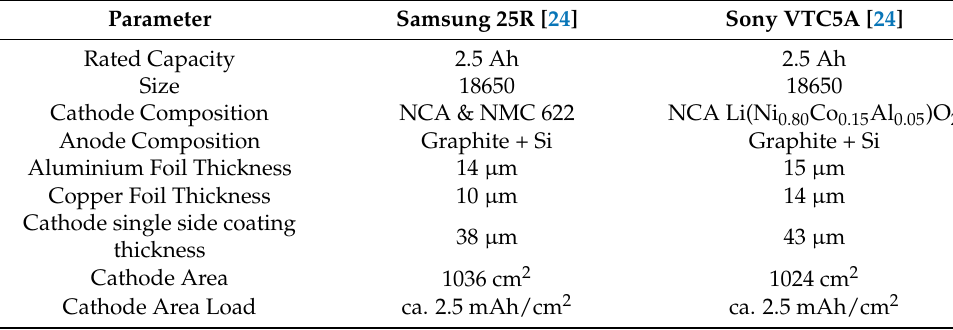
Table 1. Structure and composition of the investigated high power